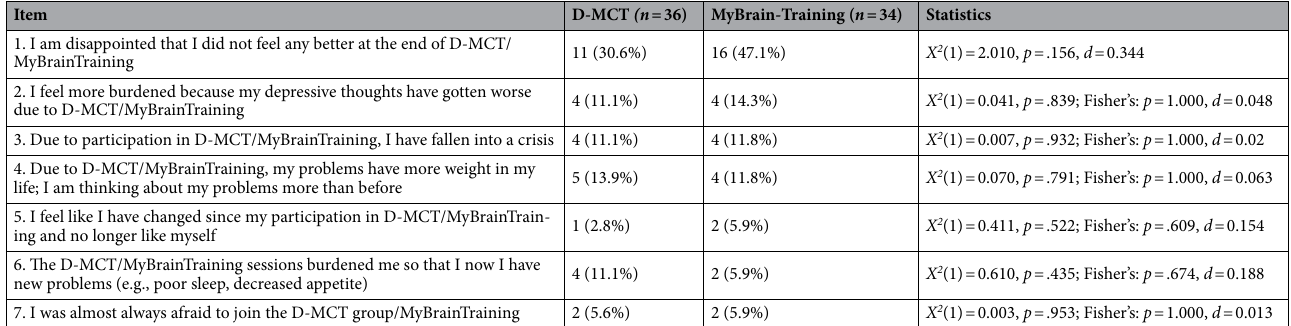
Table 2. Number of patients reporting negative effects in the SIAN (relative ratio in brackets). The reported chi-square test was based on a 2 × 2 cross table (side effects yes/no vs.